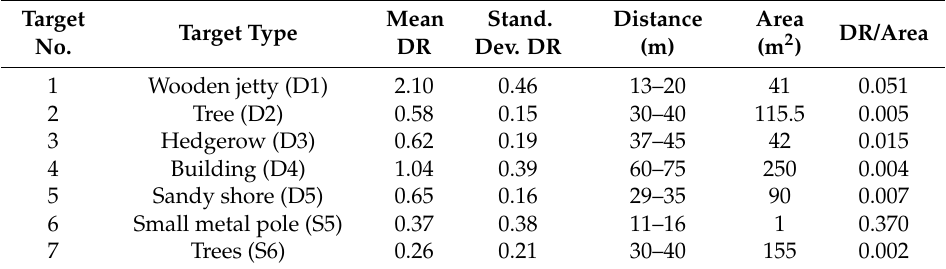
Table 7. Analysis of the possibility of detection for the dynamic